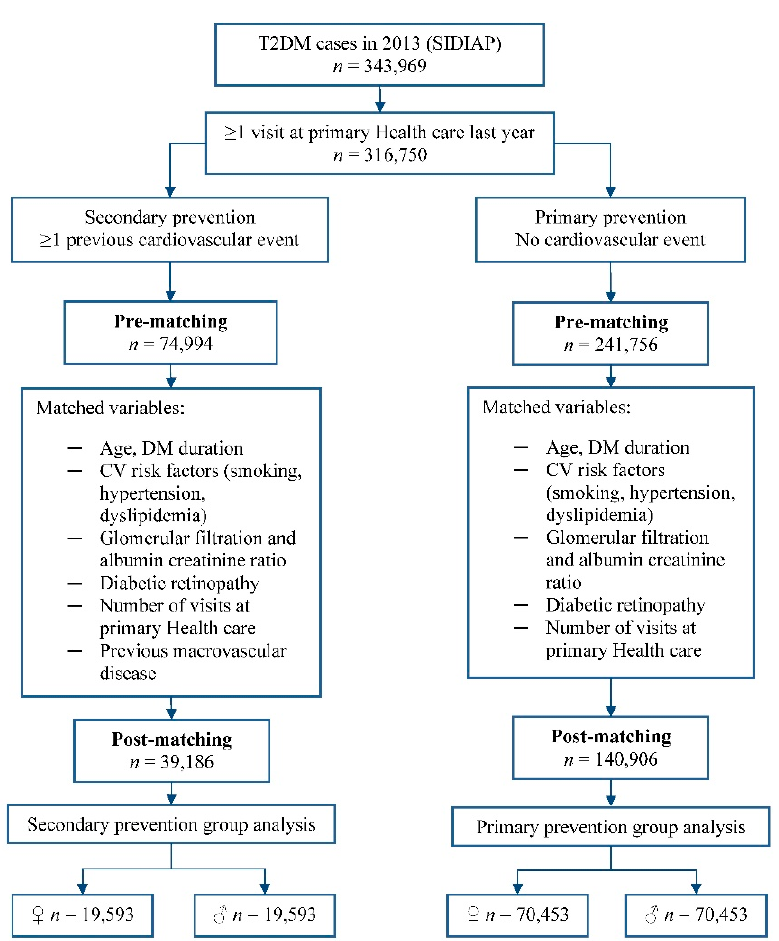
Figure 1. Flow chart of the propensity score matching procedure.